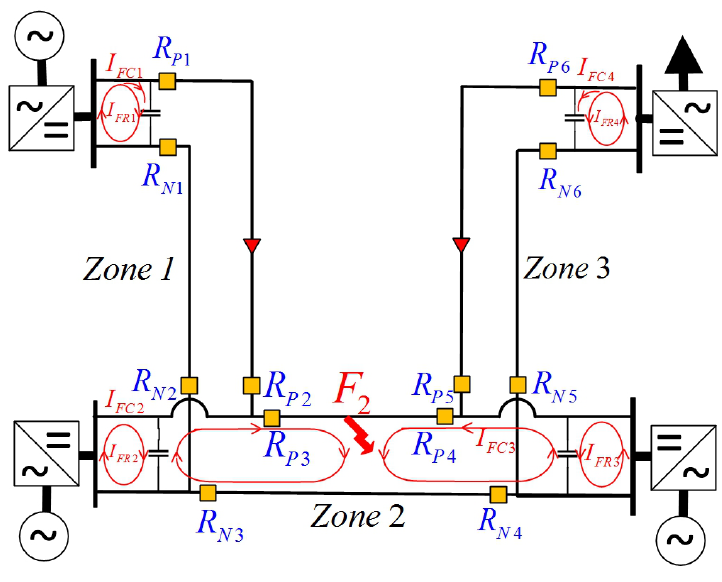
Figure 2. Analyse of FCFH current flow for an internal fault in VSC-MTDC